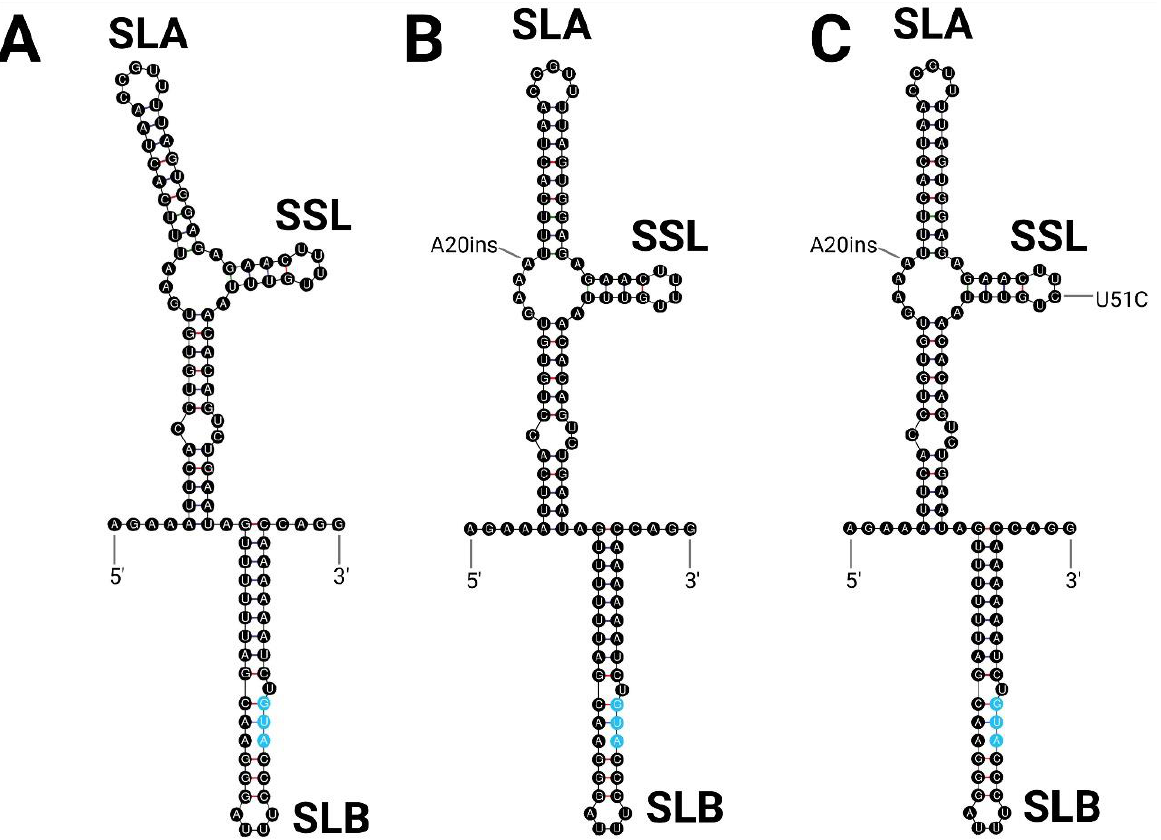
Figure 4. 5′ UTR Structure of ILHV. Predicted 5′ UTR structures of ( A ) Original and 331; ( B ) FSE 0800, PE 163615, PE 20545, H 2944, and BeH 7445; and ( C ) ZPC 659, ZPC 804, and ZCM 228 strains of ILHV. The conserved flavivirus structural domains stem–loop A (SLA), stem–loop B (SLB), and the side stem–loop (SSL) are labeled. Unique sequence features are indicated with text. The ORF start codon is indicated in blue.